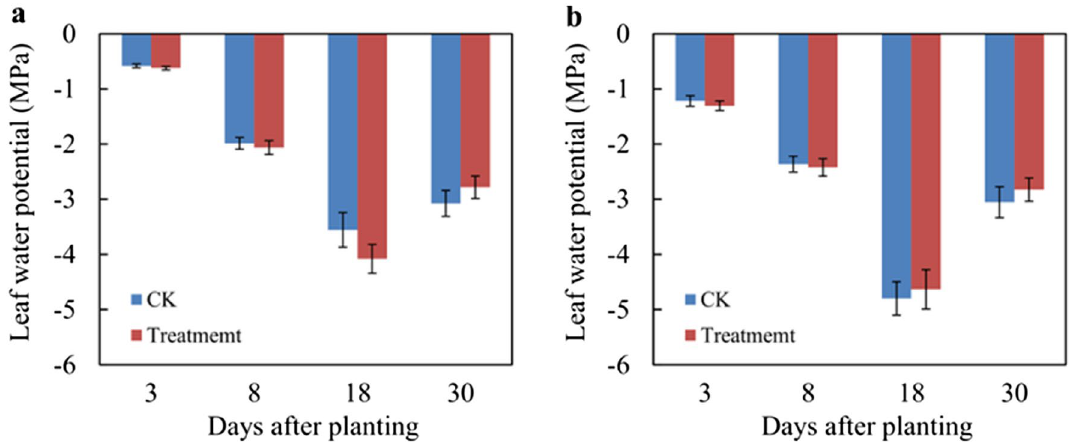
Figure 12. The Leaf water potential (ψ leaf ) of Japanese Spindle ( Euonymus japonicus ) ( a ) and Juniperus sabina ‘Tamaricifolia’ ( b ). 30 plants were used to test the leaf water potential in each treatments. Water was given immediately after transplanting, 10 days and 25 days after transplanting to kept the plants survival during 30 days of observation period.